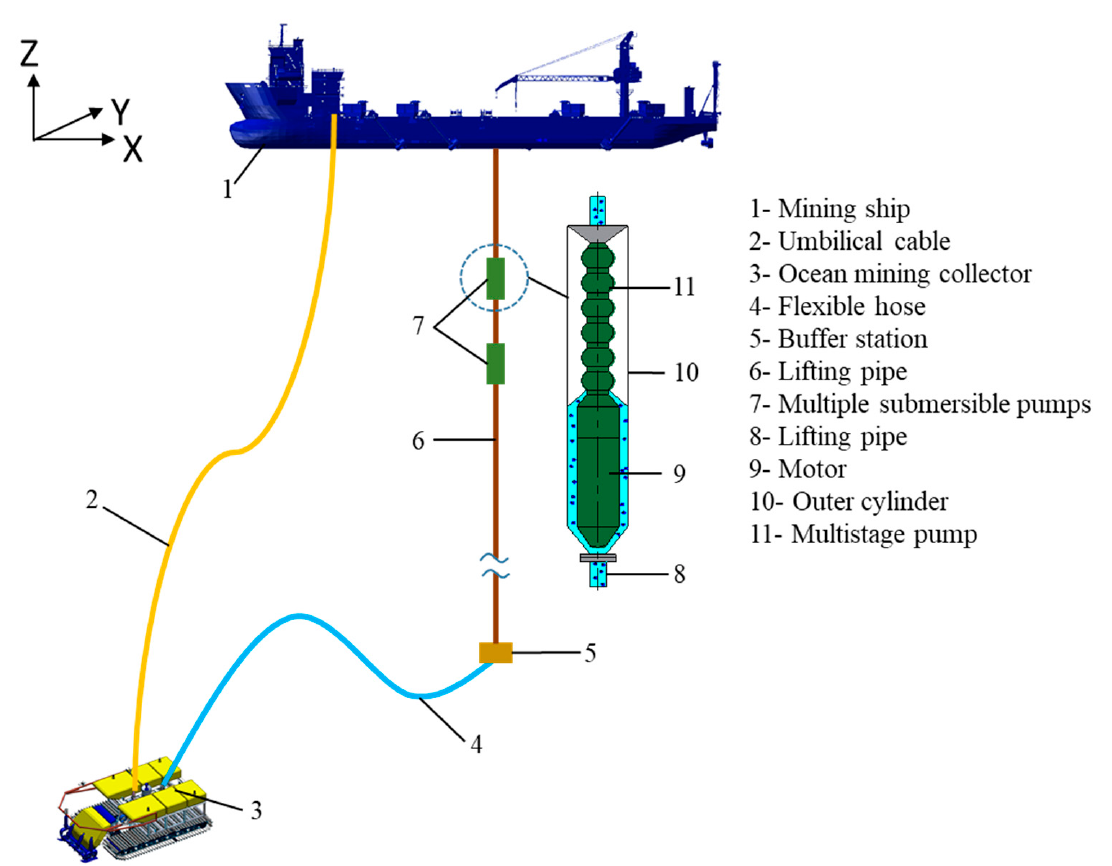
Figure 1. Schematic diagram of China polymetallic nodules deep-sea mining pilot system. In the field of studying powder rupture, the methods and models used can provide reference for us to study the degradation of nodules. Pitchumani et al. [13,14] used two different repeated impact test devices to study particle breakage. Reynolds et al. [15] reviewed the research on how new particles are generated after particle breakage. To the degradation of particles, the speed and humidity of the slurry should be considered, and the strength of the particles is also an important parameter. In addition, wet particles need to consider the porosity between the particles. At present, some physical and mechanical properties of polymetallic nodules have been measured, but researchers did not relate the measured data with particle degradation [16]. In order to explore the degradation of seabed minerals, Yamazaki [17] used a small centrifugal pump connected to a set of rectangular pipelines to test the seabed sediments in the two different mining areas for 30 min. After the test, the coarse particles became powdery particles, and it was found that the particle size would not continue to decrease after reaching a lower limit. Zenhorst [18] used a similar test device to make the polymetallic nodules slurry run ten times in the test device at a flow rate of 4 m/s and observed that the particle size will gradually approach a minimum size. The pressure of particles under the deep sea is different from the